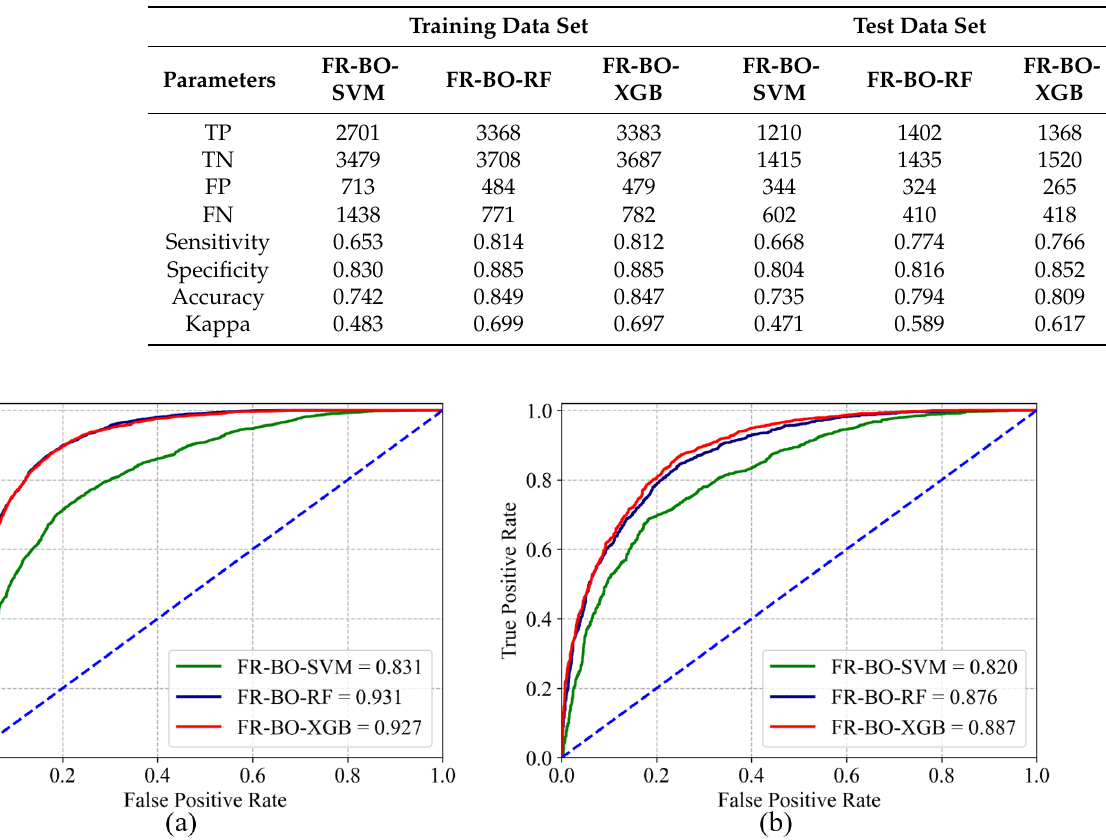
Table 2. Parameters for evaluating the predictive performance of the three models.